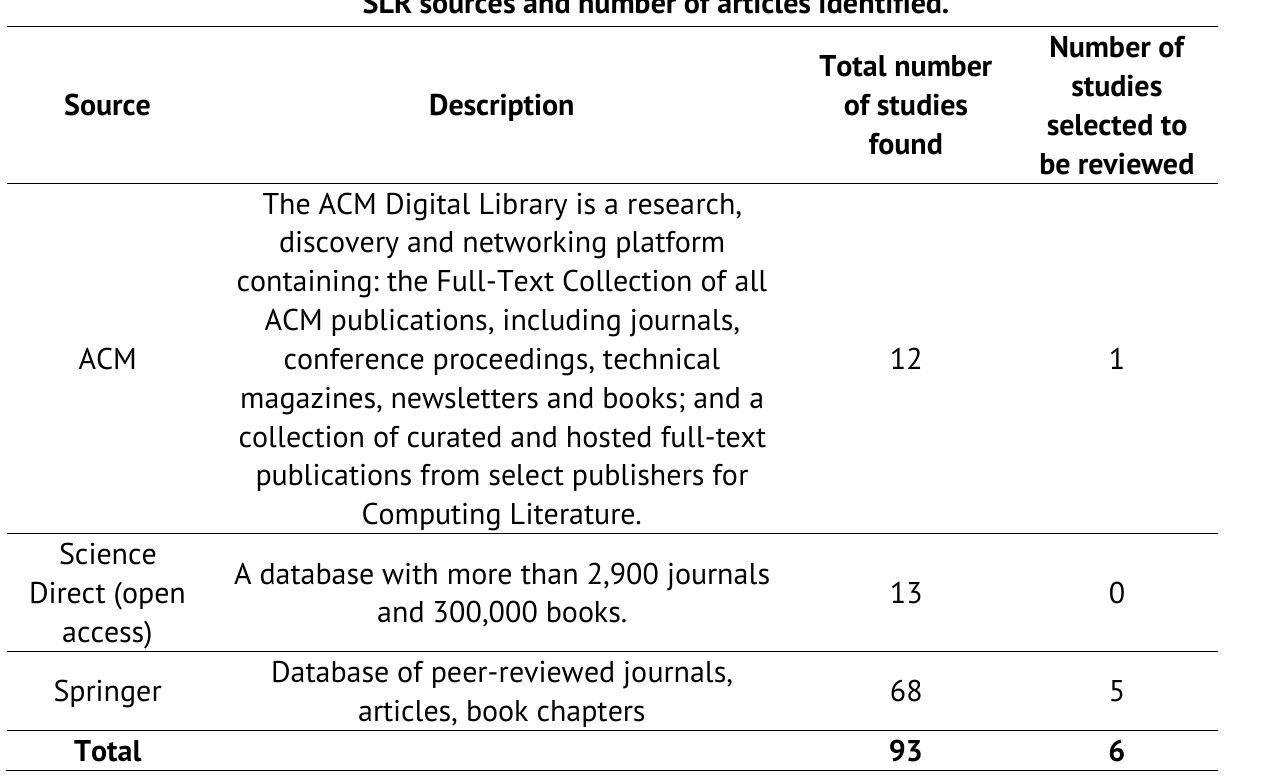
SLR sources and number of articles